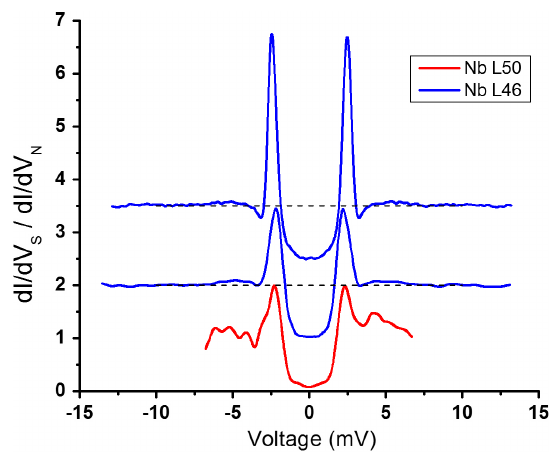
FIG. 19. Some SIS junctions obtained for samples L46 (blue) and L50 (red). The dip features seen outside the gap indicate a proximity effect of the Nb in the Au tip.